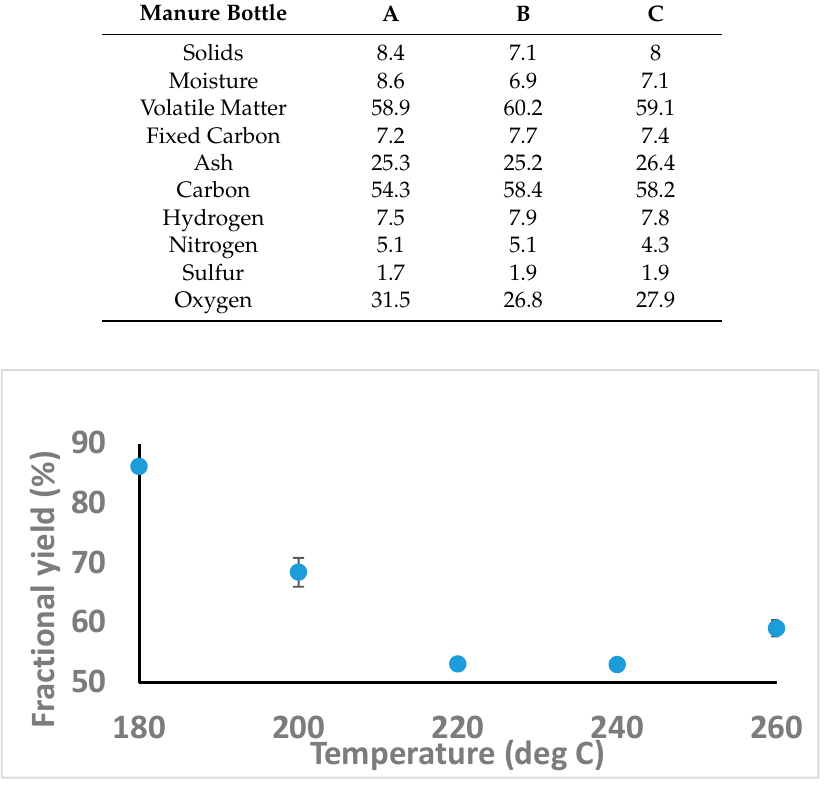
Figure 1. E ff ect of temperature on the yield of hydrochar from manure (fractional yield vs. temperature).